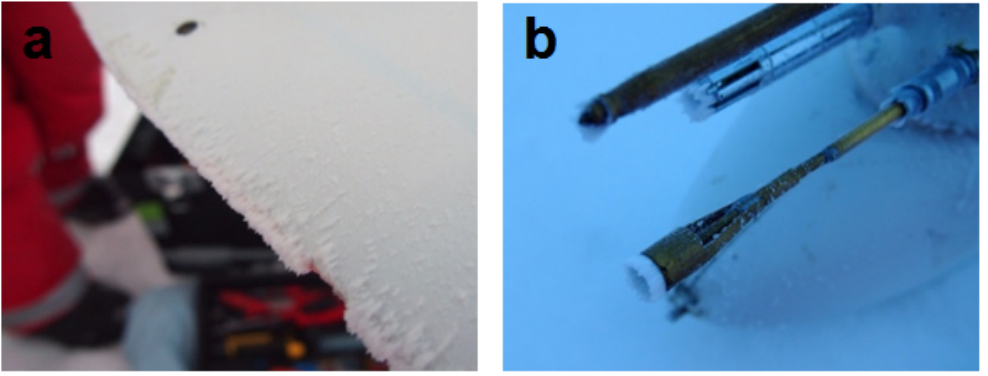
Figure 11. Ice on the wing ( a ) and meteorological sensors ( b ) of the M 2 AV after landing on 2 August 2013. Photo: Andreas Scholtz, TU Braunschweig.